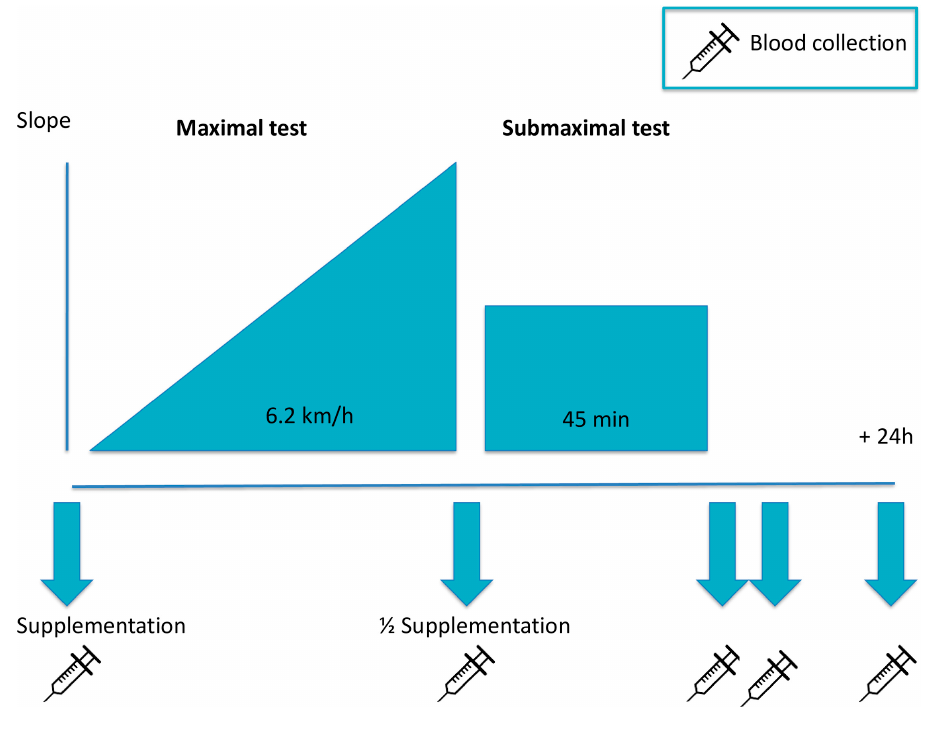
Figure 1. Protocol stages.